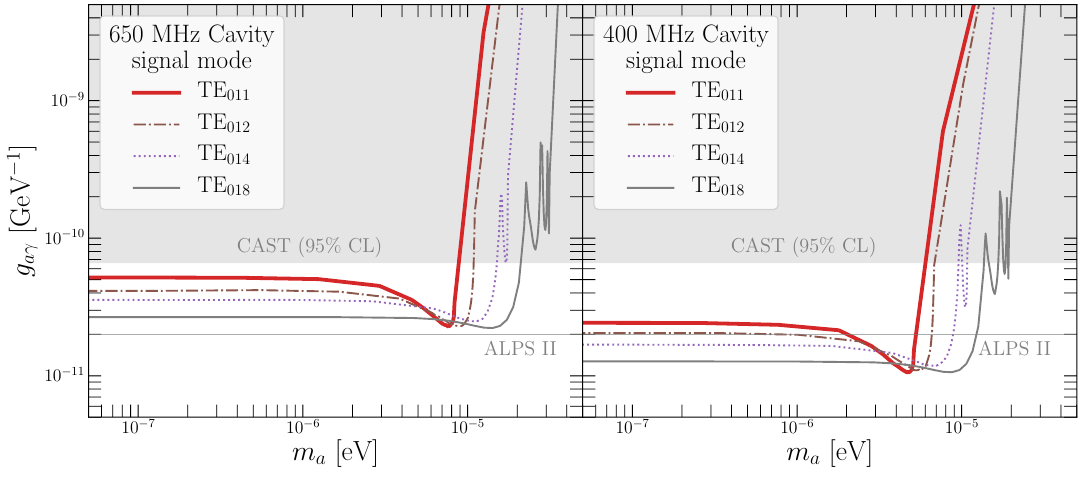
Figure 6 . Sensitivity curves (SNR = 5 ) in the plane of g aγ vs m a assuming different signal modes with a fixed spectating mode TM 010 . We use E peak = 80MV / m , Q 1 = 10 10 , T = 1 . 4K , ∆ ω 1 = t − 1 , t int = 1year . The left (right) panel assumes SRF cavities that are cylindrical with int R = L = 0 . 1766m (0 . 287m ), and are aligned in z with (0 . 1m + L) between their centers. We see that using higher modes improve sensitivity both at high ALP mass (due to higher kinematic reach) and at low masses (due to improved phase matching between a relativistic axion and excited